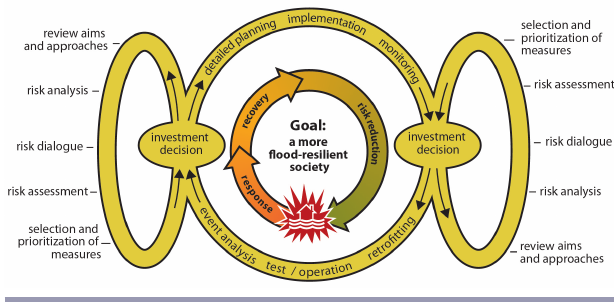
Fig. 5 . Enhanced cycle of flood risk